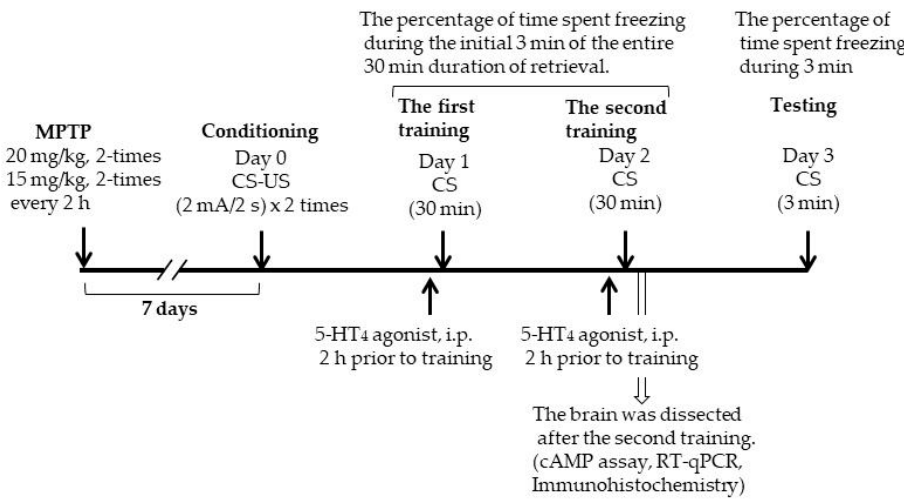
Figure 8. A schematic figure explaining the planning of the